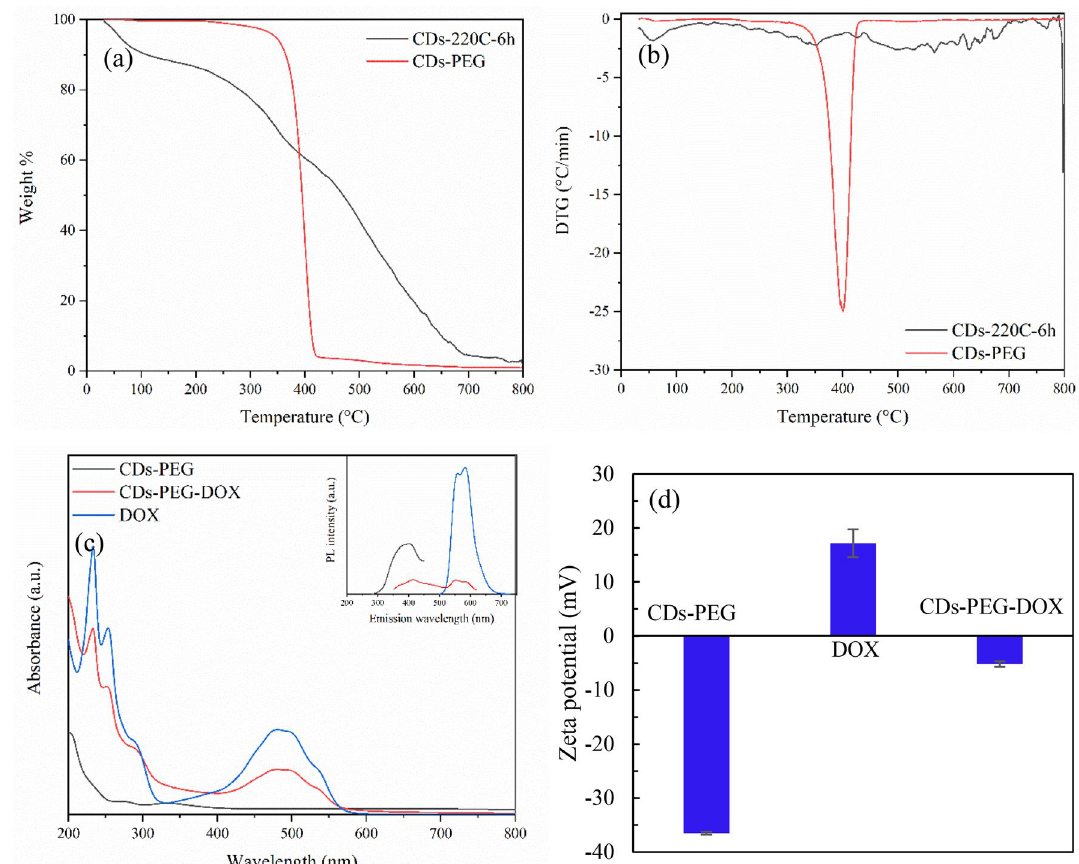
Figure 6. Thermal degradability of CDs-PEG and CDs-220C-6h; ( a ) TGA, ( b ) DTA curves under nitrogen atmosphere, ( c ) UV-Vis absorption spectra of CDs-PEG (220 °C, 6 h), DOX, and CDs-PEG-DOX. The inset shows fluorescence spectra of CDs-PEG (excitation at 240 nm), DOX (excitation at 480 nm), and CDs-PEG- DOX (excitation at 330 nm), and ( d ) the surface zeta potential of CDs-PEG, DOX, and